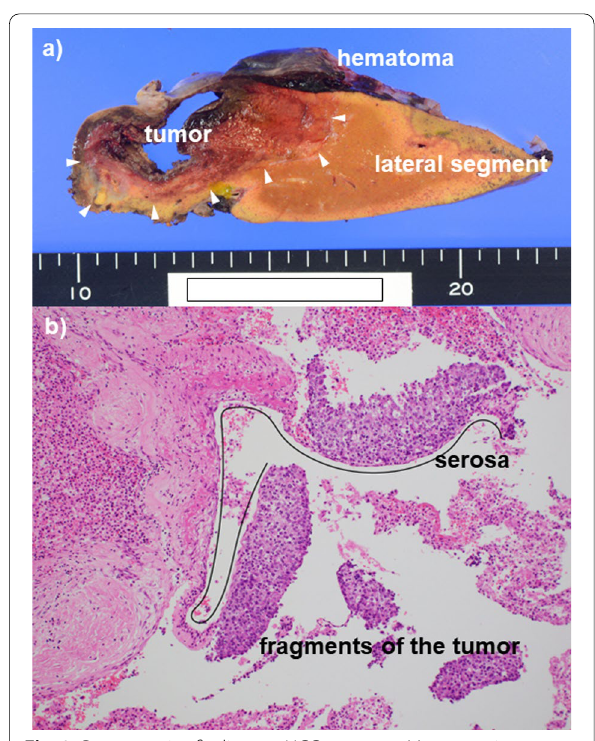
Fig. 2 Postoperative findings as HCC rupture. a Macroscopic pathology. A subserosal hematoma on the tumor and the lateral segment was observed. The hematoma was attached to the necrotic tissue of the liver parenchyma. b Microscopic pathology. Moderately differentiated hepatocellular carcinoma (HCC) was observed. Since fragments of the tumors were found outside the broken serosa of the liver, HCC rupture was histopathologically